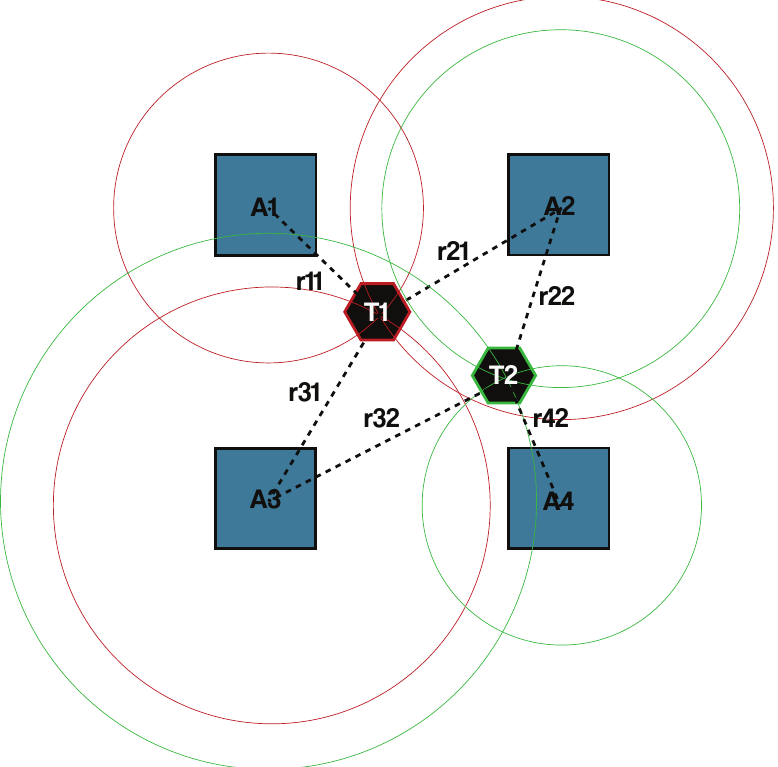
Figure 1. An example system implementing time difference of arrivals (TDOA) and trailateration based localization, where A i -s are anchor points, T i -s are UWB tags and r ij -s are